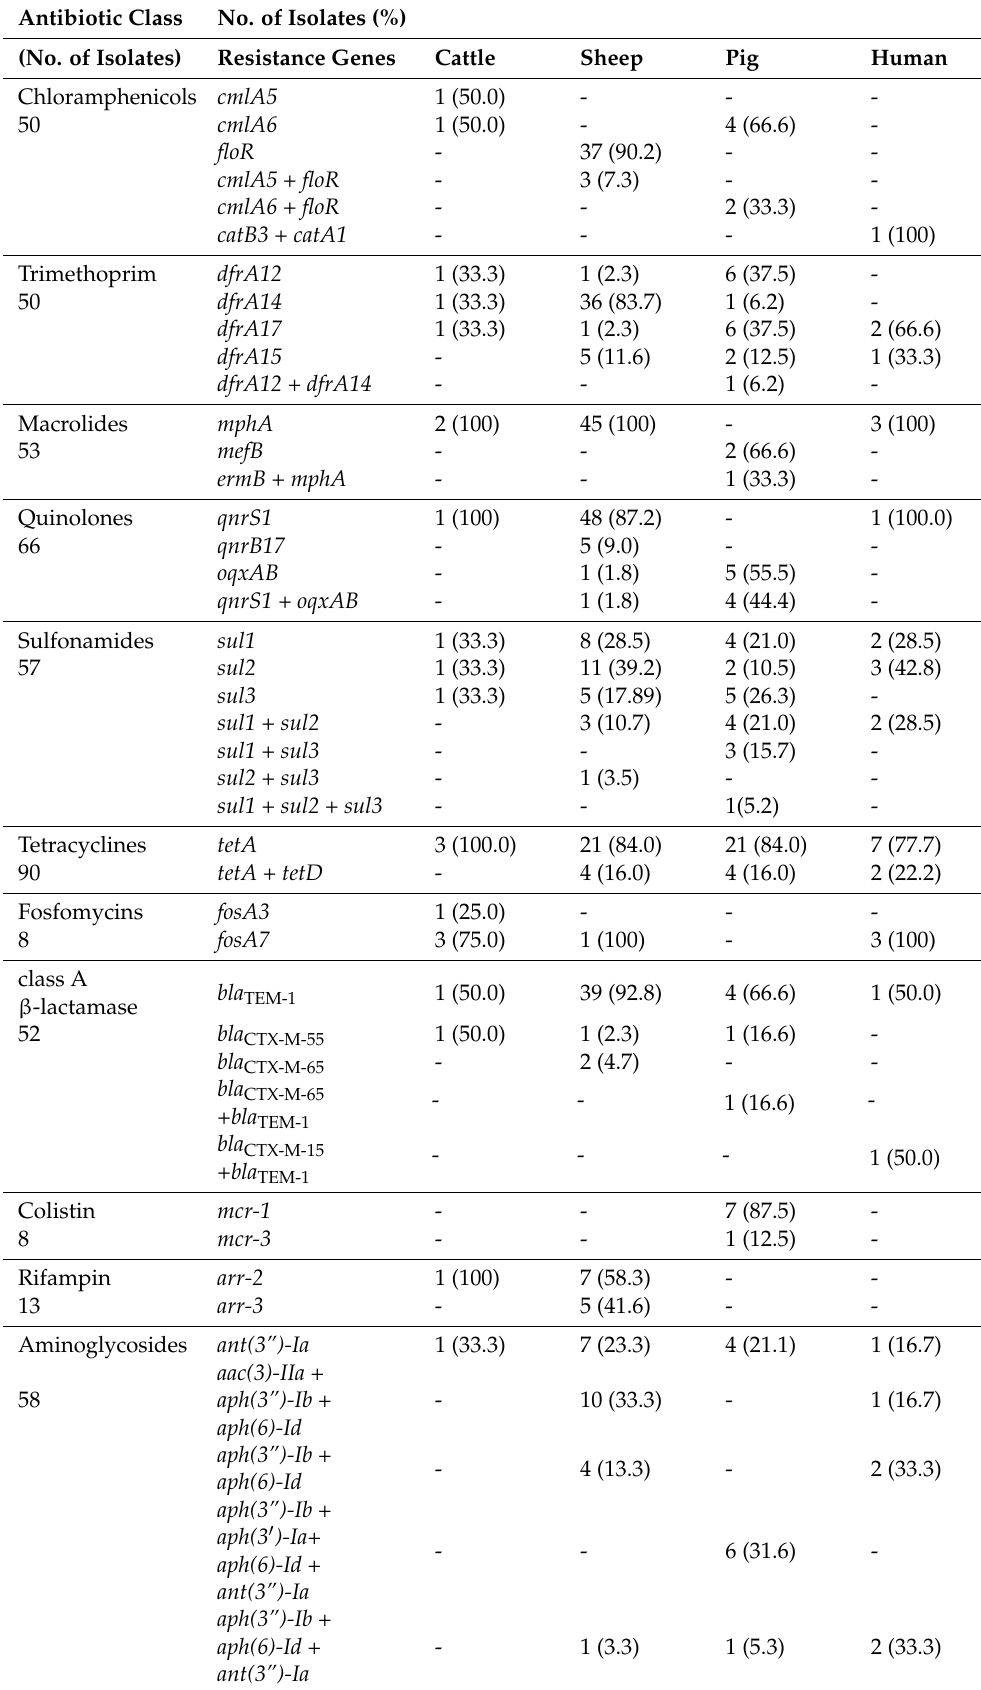
Table 2. Antibiotic resistance-related genes among the 298 genome-sequenced non-O157 STEC